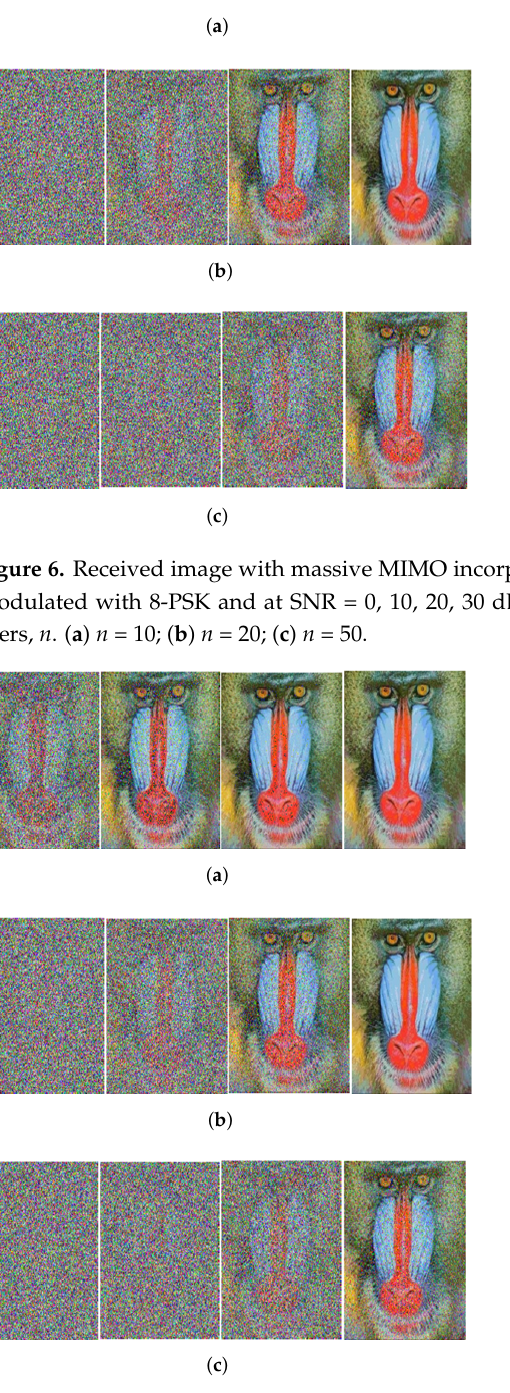
Figure 7. Received image with massive MIMO incorporated FFT-OFDM over a Rayleigh channel, Modulated with 16-PSK and at SNR = 0, 10, 20, 30 dB from Left to Right for different number of users, n . ( a ) n = 10; ( b ) n = 20; ( c ) n =